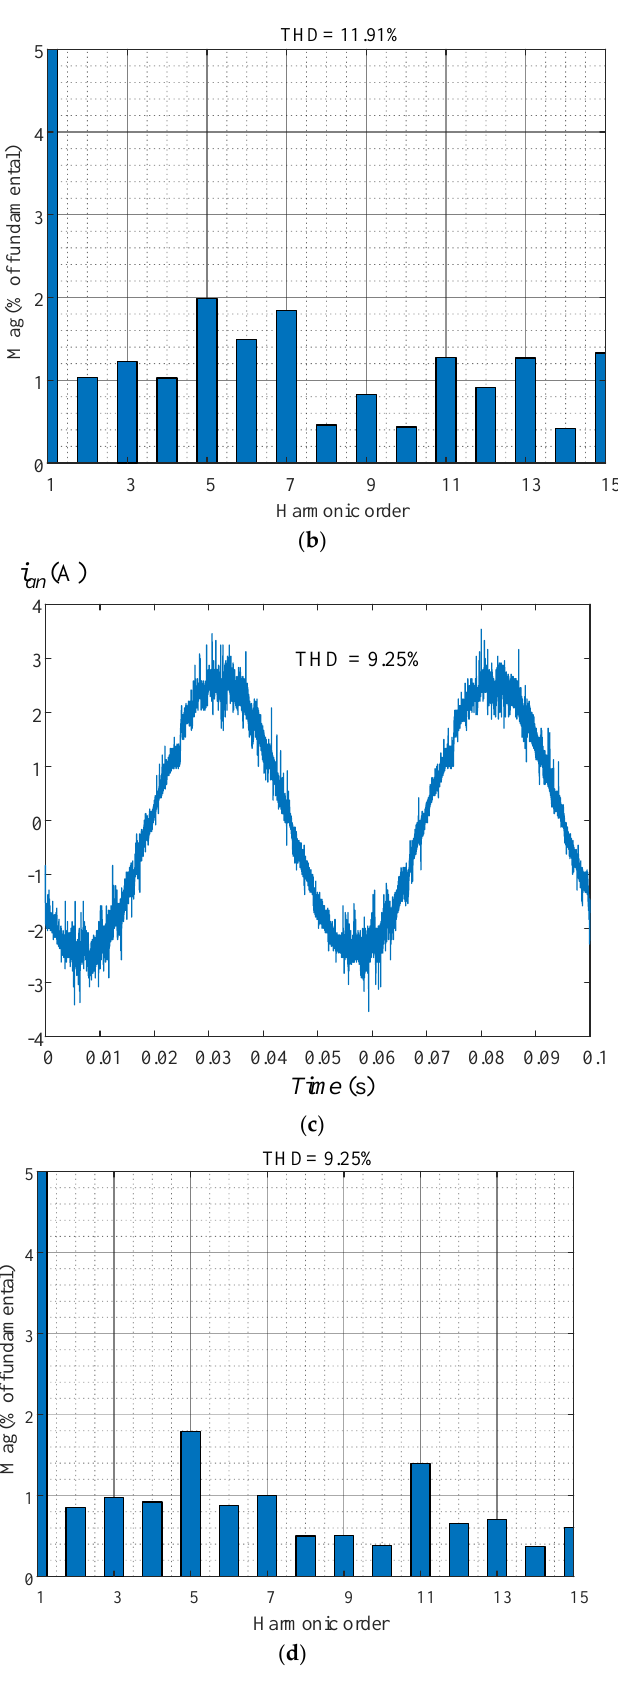
Figure 11. Measured a-phase output currents of matrix-converter using different current controllers. ( a ) PI, ( b ) THD, ( c ) predictive, ( d ) THD.